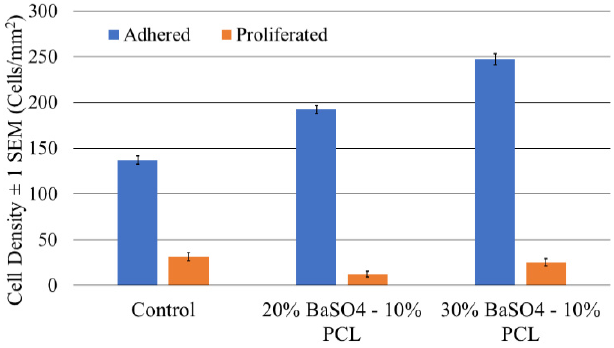
Figure 6. Average cell density ± 1 standard error bars of adhered and proliferated endothelial cells on PCL tiles with and without BaSO 4 coating incubated for 24 h.